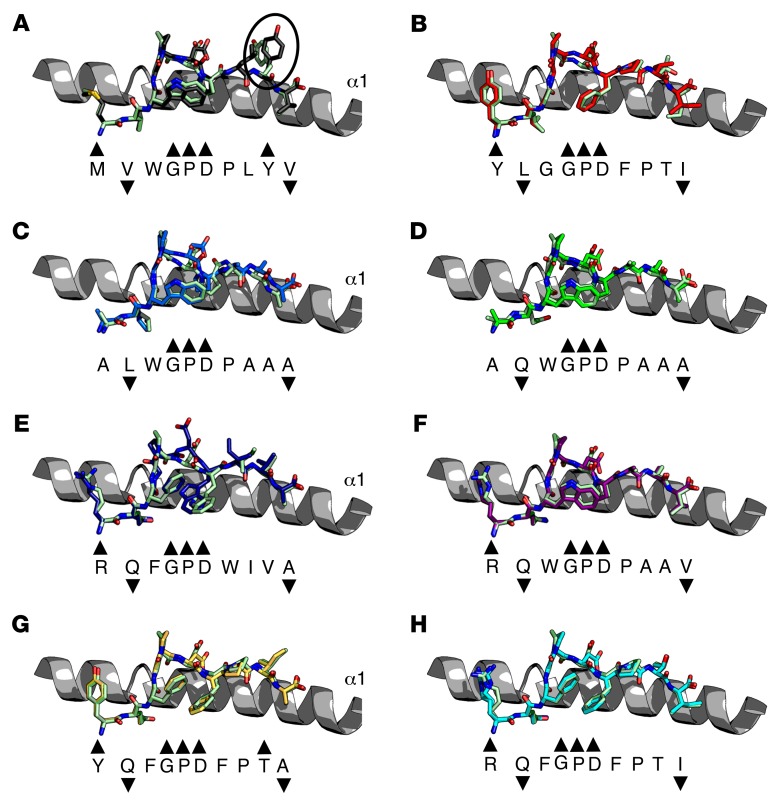
Comparison of ligated and unligated APLs.Superposition of each APL in unligated form and ligated to the 1E6 TCR. All unligated pMHCs are shown as light green illustrations. Peptide sequences are shown underneath each structure aligned with the peptide structure. Black arrows denote the direction of the side chain. Upward arrows indicates solvent exposed, downward arrows indicates anchor position, and no arrow indicates an intermediate position. (A) A2-MVWGPDPLYV (black sticks). A large conformational shift was observed for Tyr8 in the ligated versus unligated states (black circle). (B) A2-YLGGPDFPTI (red sticks). (C) A2-ALWGPDPAAA (blue sticks) reproduced from previous published data (21). (D) A2-AQWGPDPAAA (green sticks). (E) A2-RQFGPDWIVA (dark blue sticks). (F) A2-RQWGPDPAAV (purple sticks). (G) A2-YQFGPDFPTA (yellow sticks). (H) A2-RQFGPDFPTI (cyan sticks).